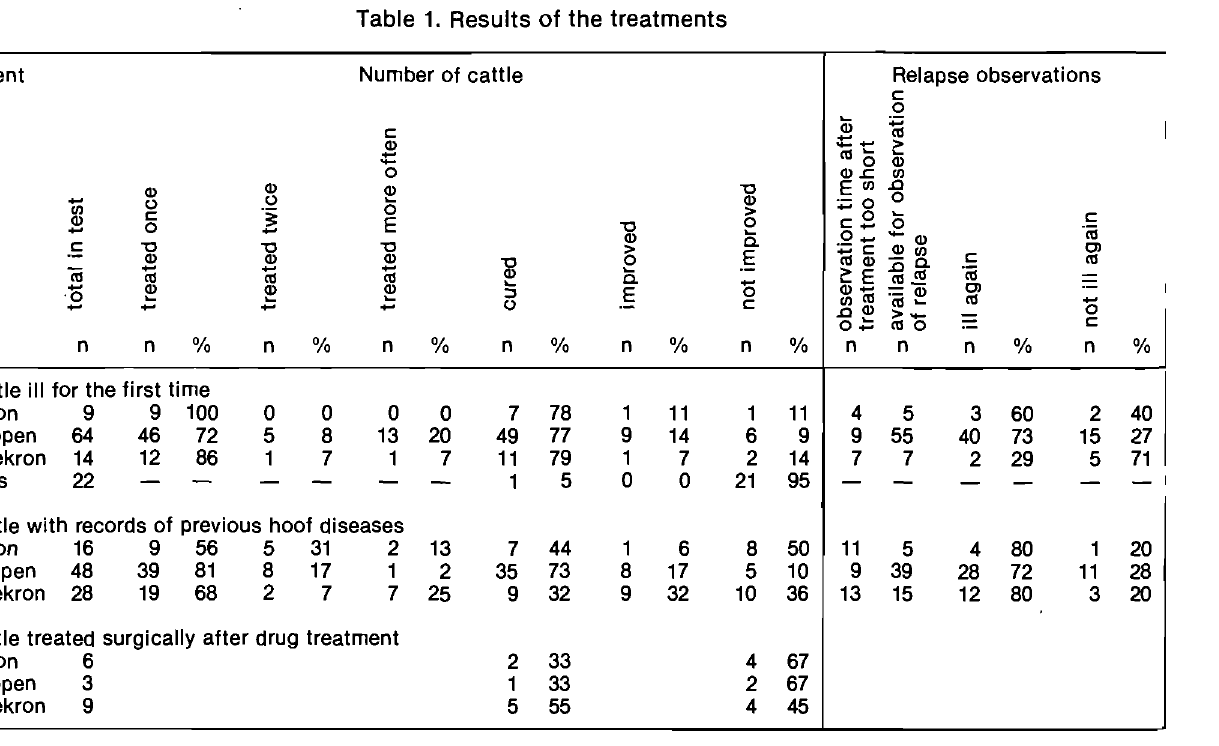
Treatment Number of cattle Relapse observations